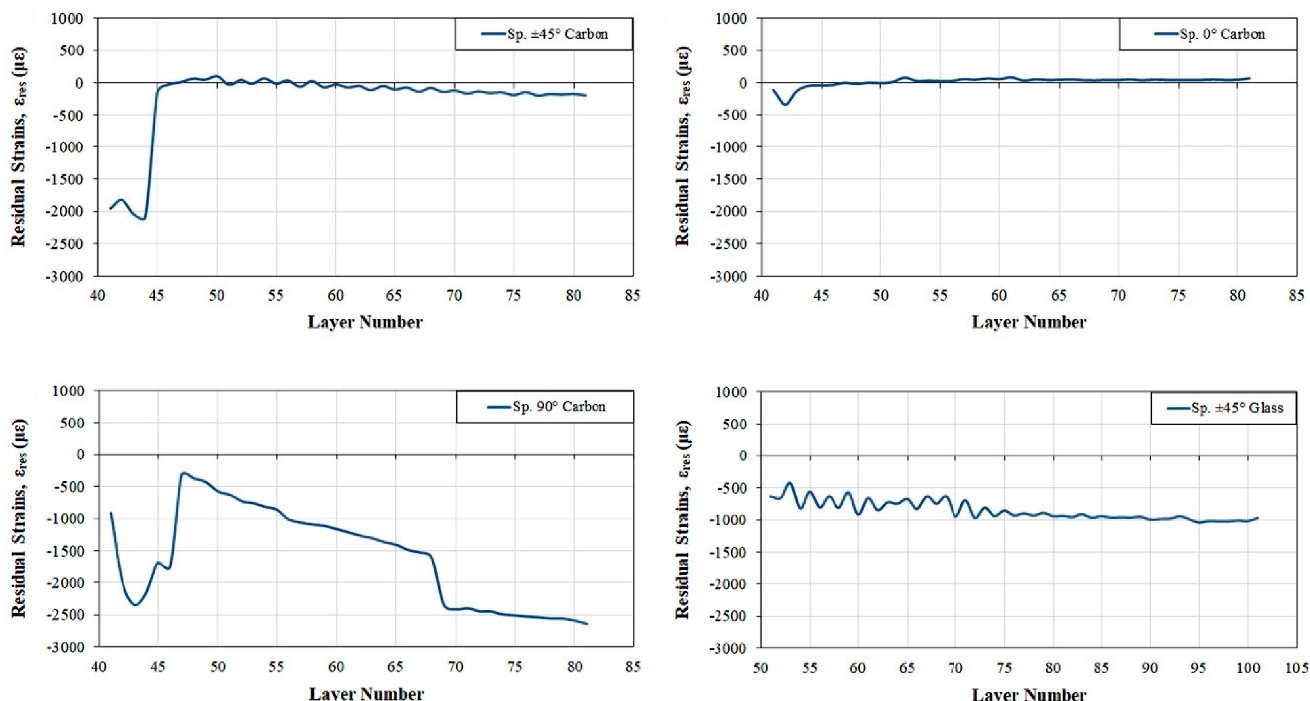
Figure 8. ( a ) Schematic of the midplane of a 0° fiber reinforcement orientation of a 3D printed CFRTPC with the location of the FBG sensor and the thermocouple, and ( b ) picture of a 3D printed CFRTPC specimen containing an embedded FBG sensor and a thermocouple [71] (copyright (2019), with permission from Elsevier).